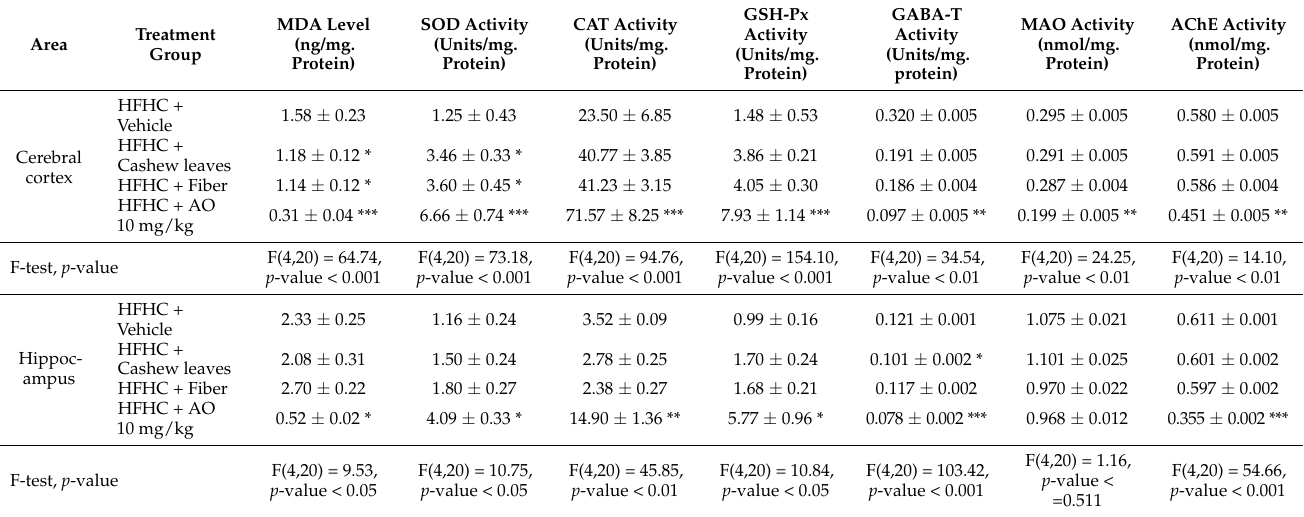
Table 9. Changes in oxidative stress markers including malondialdehyde (MDA), superoxide dis- mutase (SOD), catalase (CAT), and glutathione peroxidase (GSH-Px), and the activities of acetyl- cholinesterase (AChE), monoamine oxidase (MAO), and gamma aminobutyric acid transaminase (GABA-T) in cerebral cortex and hippocampus of metabolic syndrome